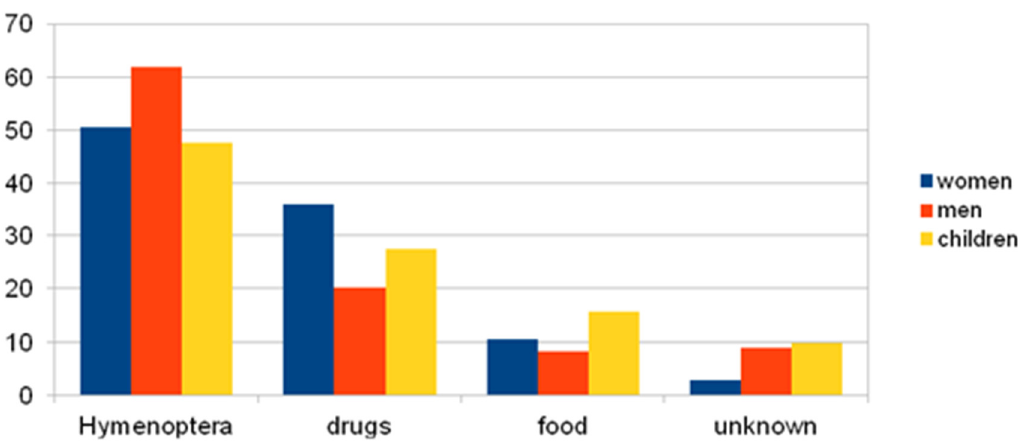
Figure 7. Triggers of anaphylaxis in the analysed groups of women, men, and children (%). Table 2. p -value between groups, taking into account the reasons. p -Value